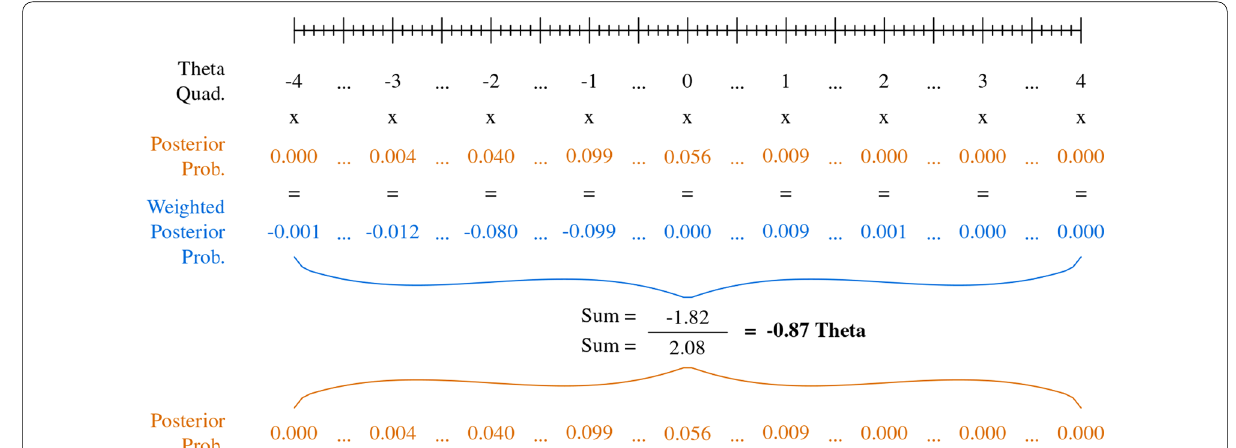
Fig. 7 Calculation of theta for PROMIS Fatigue item FATEXP42, Not at all response option